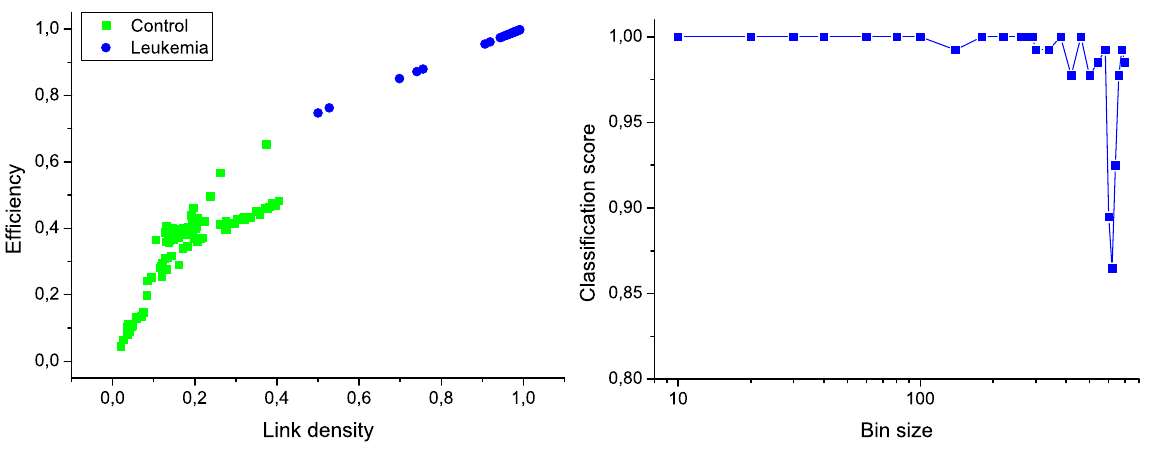
Figure 6. Classification of control and leukemia subjects. (Left) Representation of the position of control subjects (green squares) and leukemia patients (blue points) in the space of network features. (Right) Classification score as a function of the binning